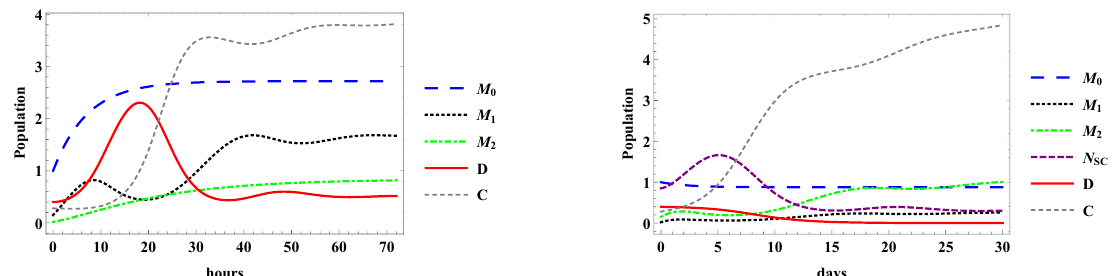
Figure 3. The behaviour of the SMD model within 72 h from stroke onset and the SMNR model within 30 days after stroke